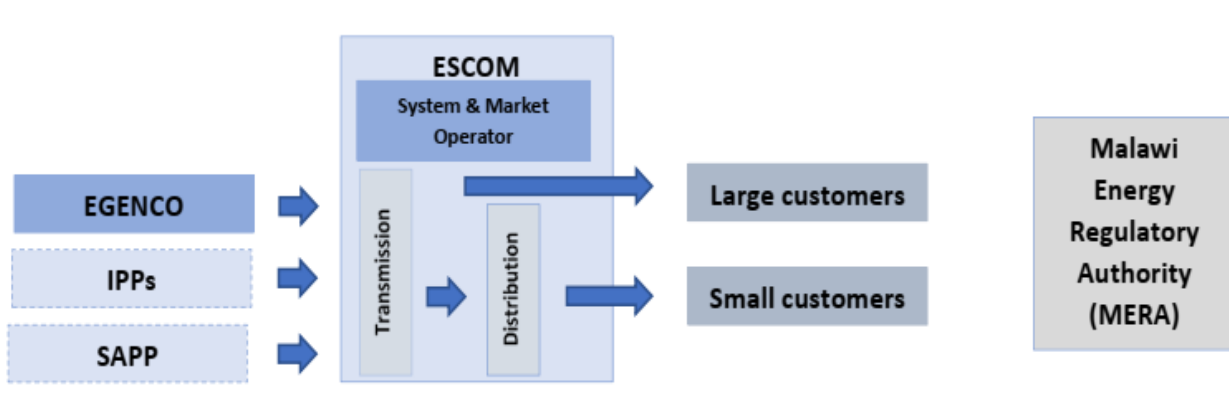
Figure 2. Electricity market structure in Malawi (adapted from [25]).